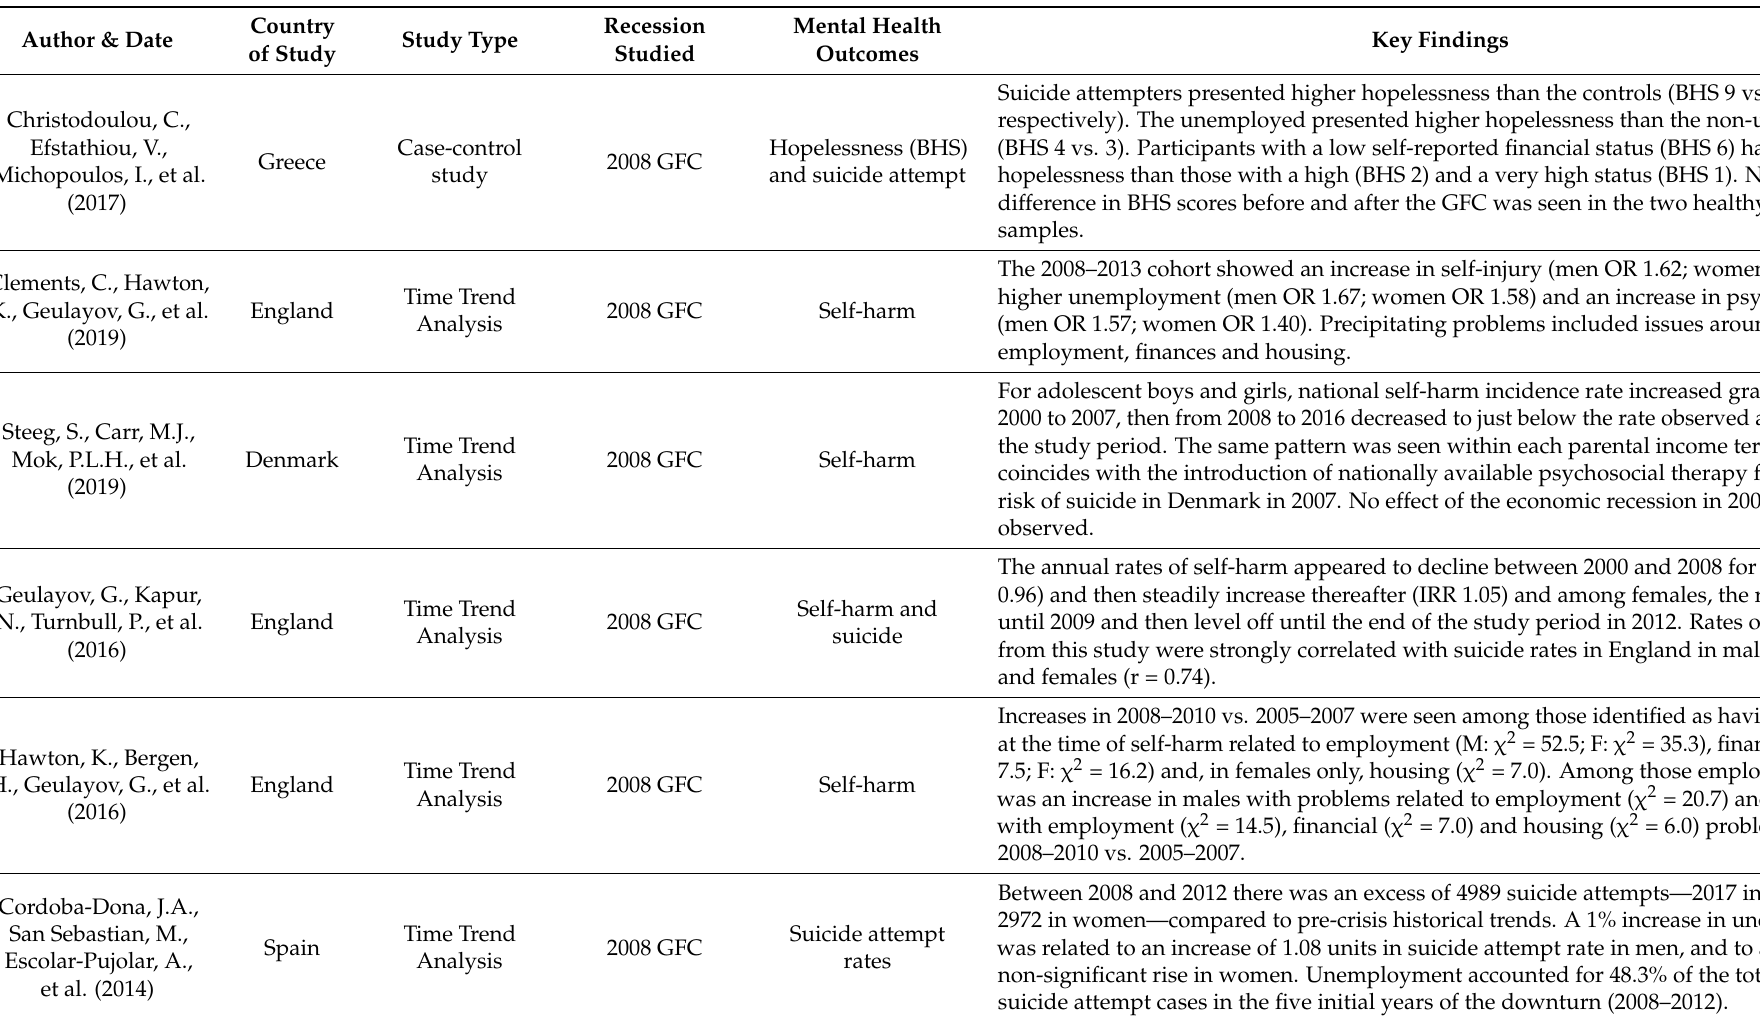
Table 3. Summary of included articles on suicidal ideation and self-harm (N =